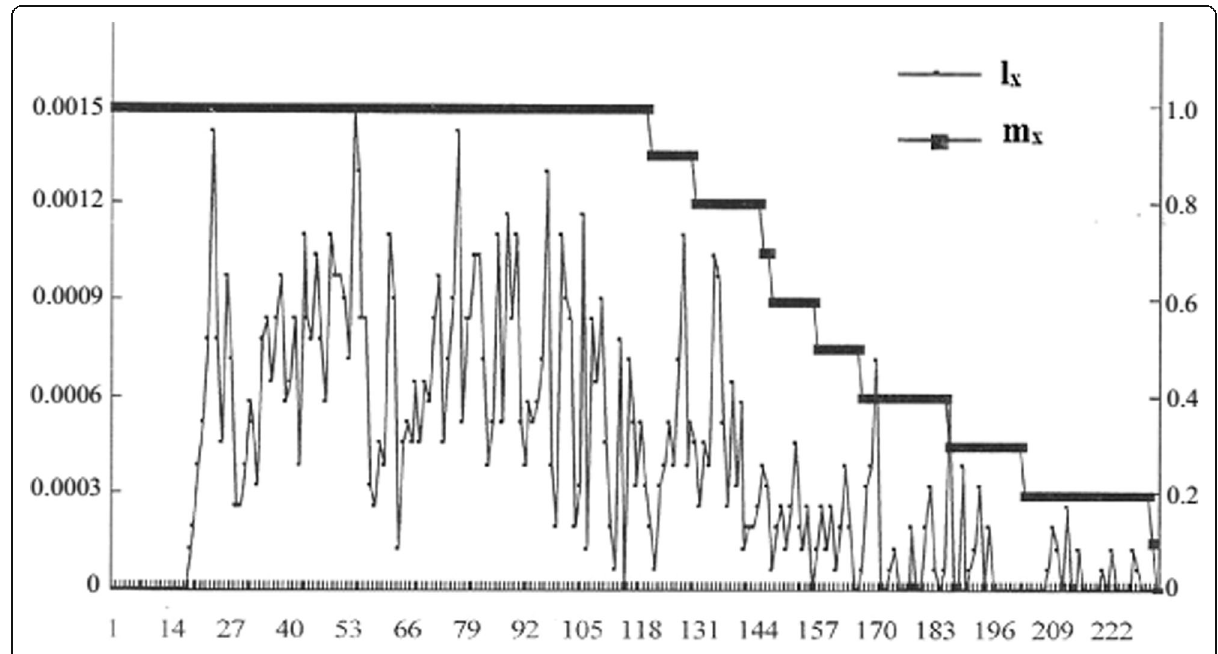
Fig. 3 Trends of age-specific survival rate ( l x ) and age-specific fecundity ( m x ) of C. brachylobus adult on whitefly